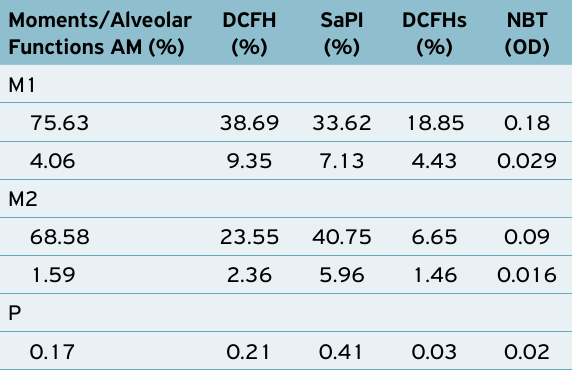
Figure 1. Cytogram of alveolar macrophage´s ROS stimulated calves at basal and immunosuppressing moment. Table 1. Means (SEM) AM percentage and their functions of calves at basal (M1) and immunosuppressing moment